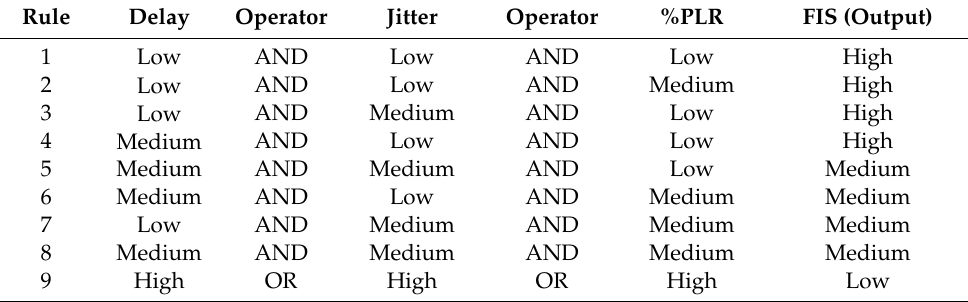
Table 1. The rules for the FIS1 knowledgebase.